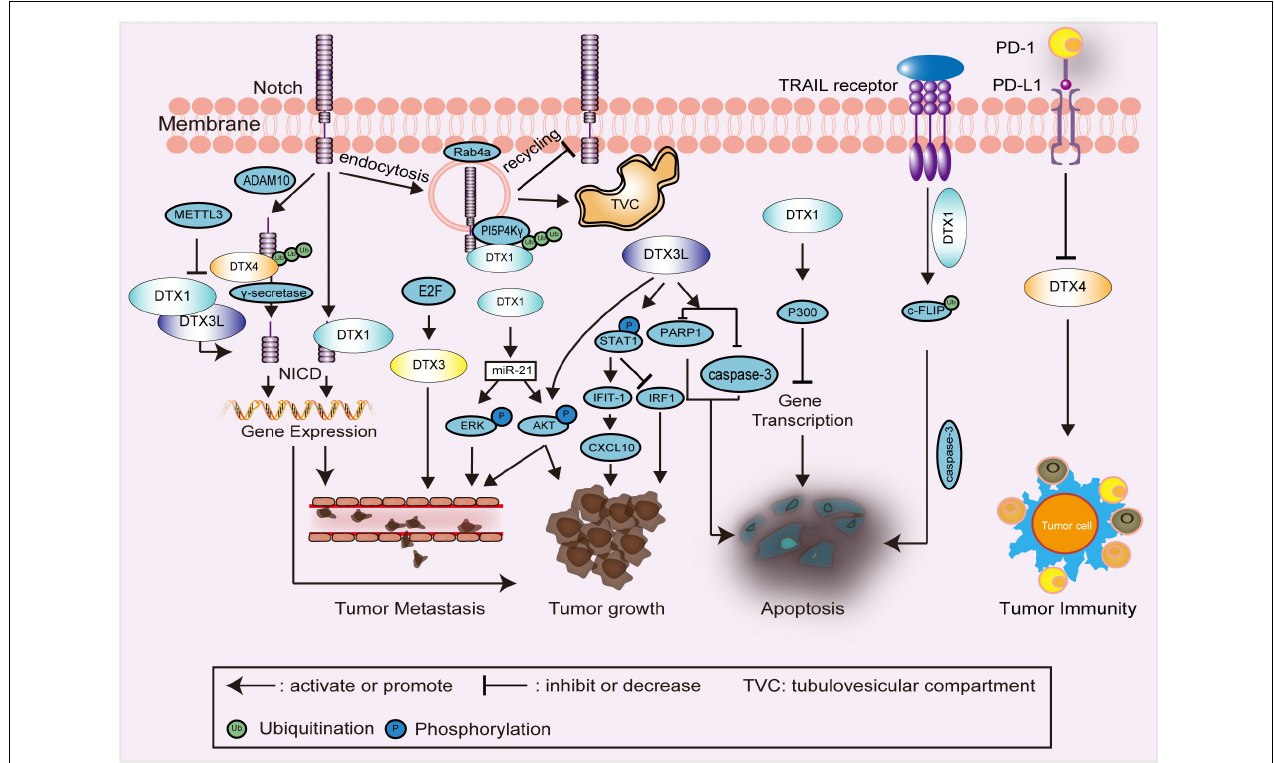
FIGURE 4 | Schematic diagram showing DTX family related signaling pathways and interactions in carcinomas. In the regulation of Notch endocytosis, ubiquitination of PI5P4K γ , as a substrate of DTX1, promotes the endocytosis and maintaining of Notch on the membrane of TVC, thereby restraining the recycling of Notch to the cell membrane. DTX family proteins, such as DTX1, DTX3L, and DTX4, are primarily involved in the regulation of the Notch signaling pathway and expression of downstream genes to affect tumor growth, and metastasis. In the regulation of tumor growth and metastasis, DTX1 and DTX3L also enhance the phosphorylation of downstream proteins, such as STAT1, AKT, and ERK. In the regulation of apoptosis, ubiquitination of c-FLIP by DTX1 stimulates TRAIL-induced cell death. The combination of P300 and DTX1 inhibits the expression of multiple genes, which is also associated with apoptosis. The expression of caspase-3 and PARP1 is decreased by DTX3L to inhibit apoptosis. In the regulation of tumor immunity, the expression of DTX4 is negatively regulated by PD-L1. NICD, intracellular domain of Notch receptor; PI5P4K γ , phosphatidylinositol-5-phosphate 4-kinase γ ; TVC, tubulovesicular compartment; STAT1, signal transducer and activator of transcription 1; c-FLIP, cellular FADD-like interleukin-1 β converting enzyme inhibitory protein; TRAIL, TNF-related apoptosis-inducing ligand; PARP1, poly (ADP-Ribose) polymerase 1; PD-L1, programmed death ligand 1; METTL3, methyltransferase-like 3; ADAM10, a disintegrin and metalloproteinase 10; IFIT-1,